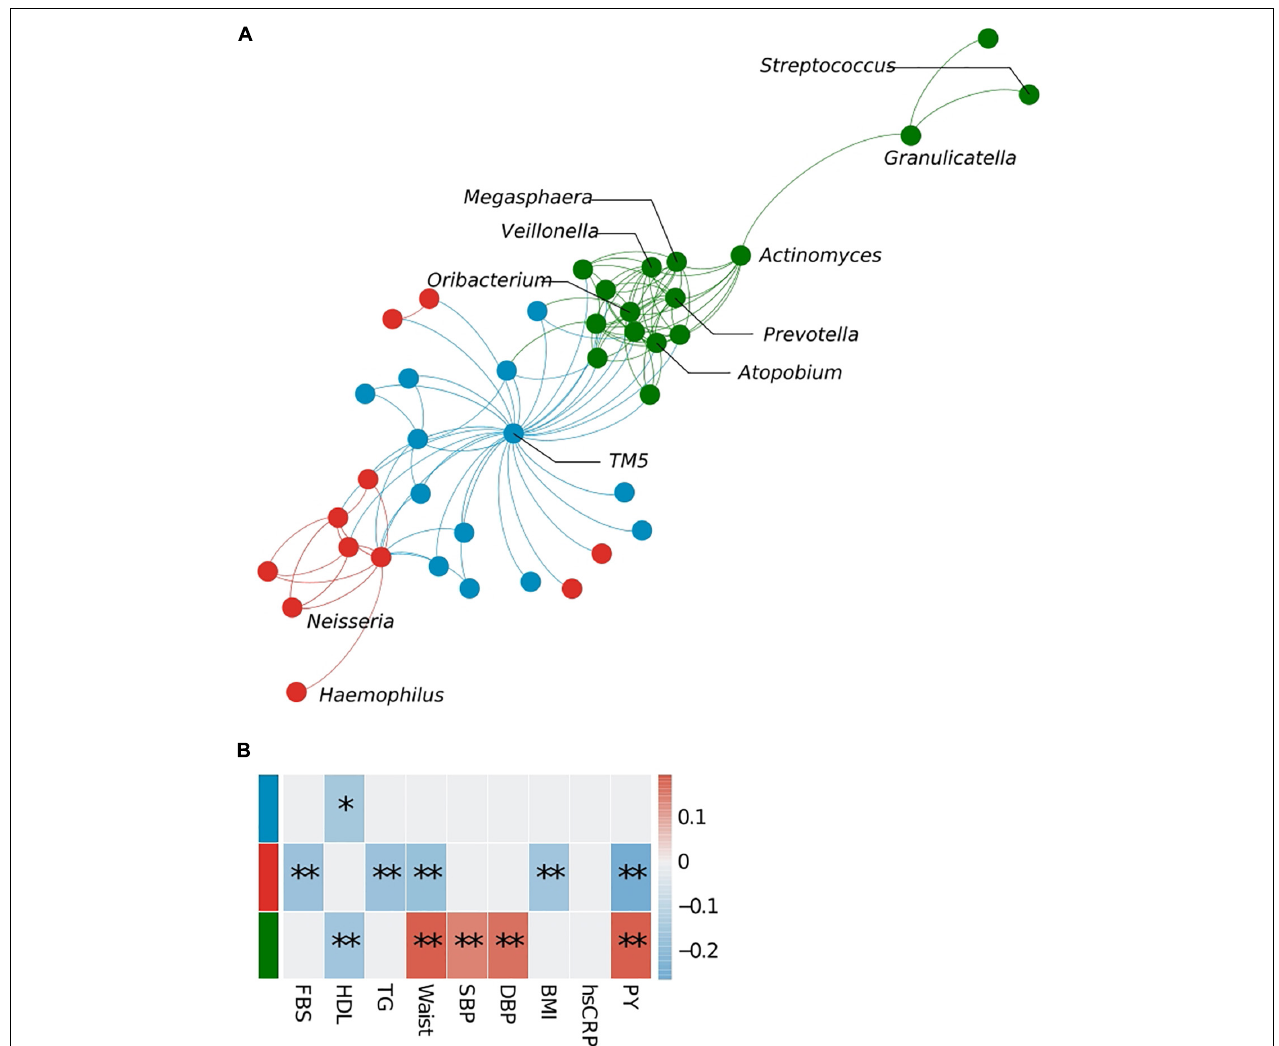
FIGURE 3 | Bacterial cluster analysis in the sputum microbiota. (A) Microbial network at the genus level. Different colors represent different microbial clusters. (B) The Pearson correlation analysis of eigenvectors between each cluster and host clinical variables. Cluster colors (red, blue, and green) correspond with those shown in panels (A,B) . FBS, fasting blood sugar; HDL, high-density lipoprotein cholesterol; TG, triglycerides; SBP, systolic blood pressure; DBP, diastolic blood pressure; PY, pack-years. ∗ p < 0.05, ∗∗ q <